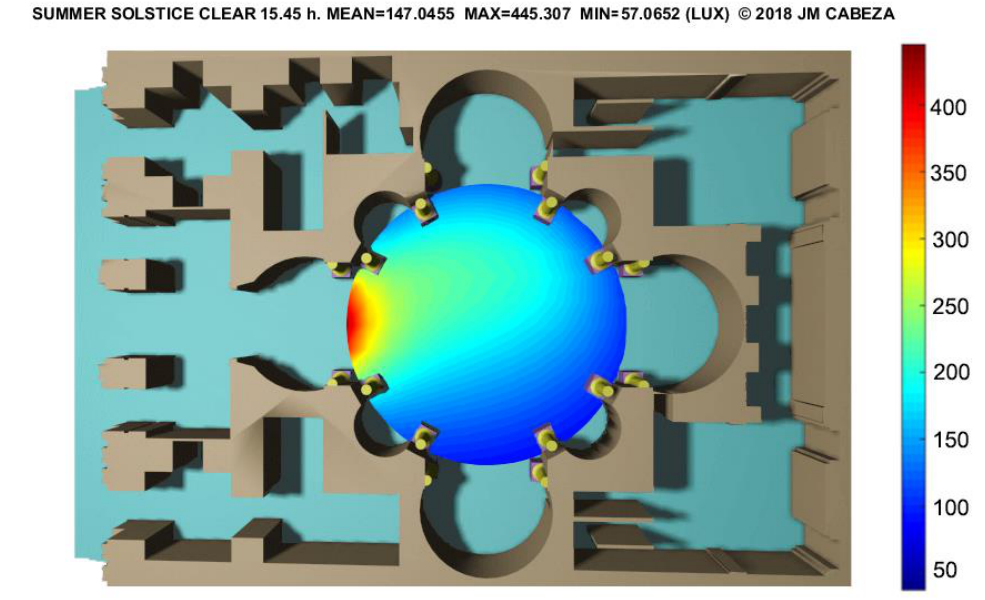
Figure 6. Summer standard sunny day. Reversed in the vertical axes at 8.45 h. Source: